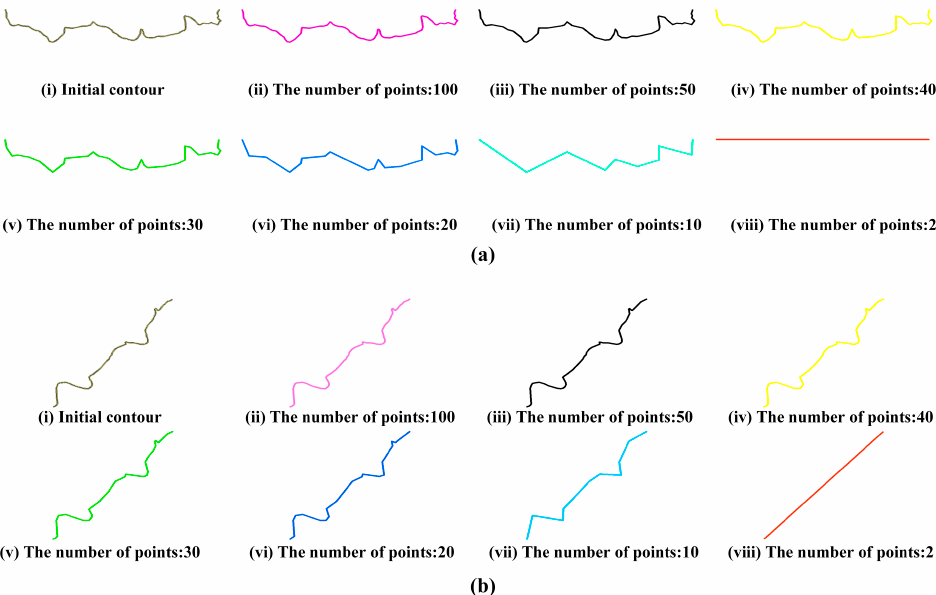
Figure 15. Two selected contours and the corresponding target contours with different point numbers. ( i ) Initial contour. ( ii – viii ) Target contours with 100, 50, 40, 30, 20, 10, and 2 points, respectively. ( a , b ) represent two contours with different shapes randomly selected from the initial contour set.